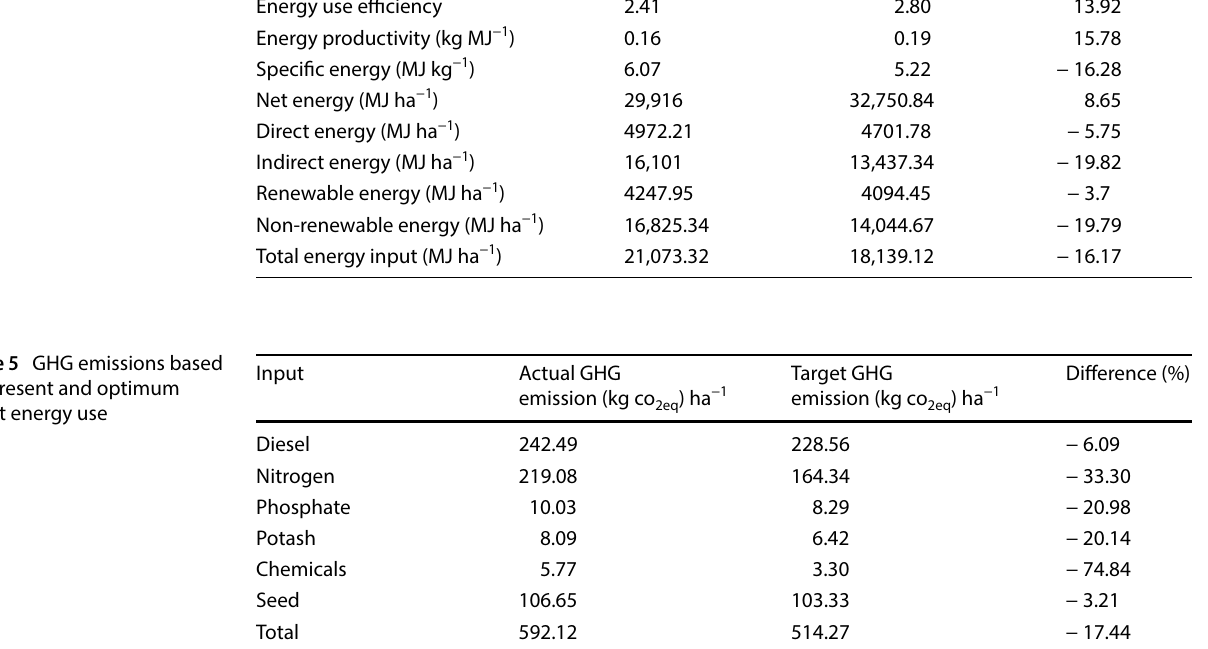
Table 4 Present and optimized energy indices for wheat production